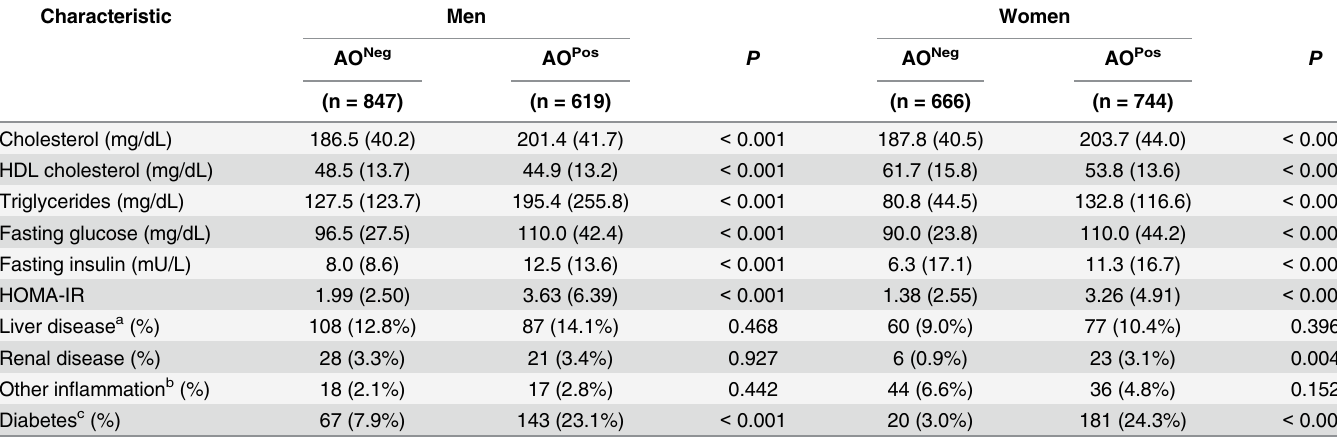
Table 2. Distribution of biochemistry examination and chronic diseases in participants with abdominal obesity (AO Pos ) and without (AO Neg ). [Mean (SD) or Number (%)].